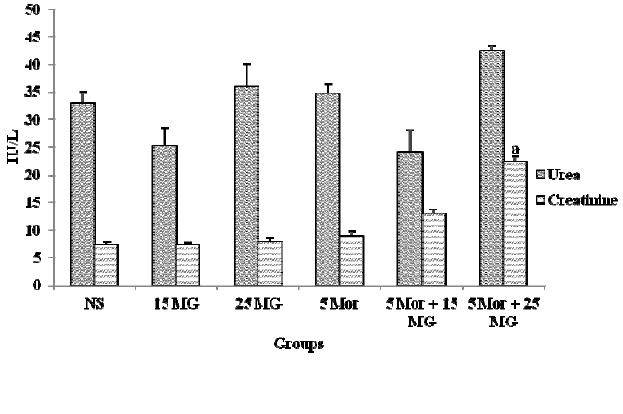
Figure 6. The levels of urea and creatinine in control group (normal saline), mitragynine (15 mg/kg, 25 mg/kg), morphine (5 mg/kg) and combination groups (5 mg/kg Mor + 15 mg/kg; 5 mg/kg Mor + 25 mg/kg). Each column represents the mean ± SEM of IU/L of seven animals in each group (n = 7). Values are statistically siginficant at p < 0.05. a: Combination treatment group compared with control